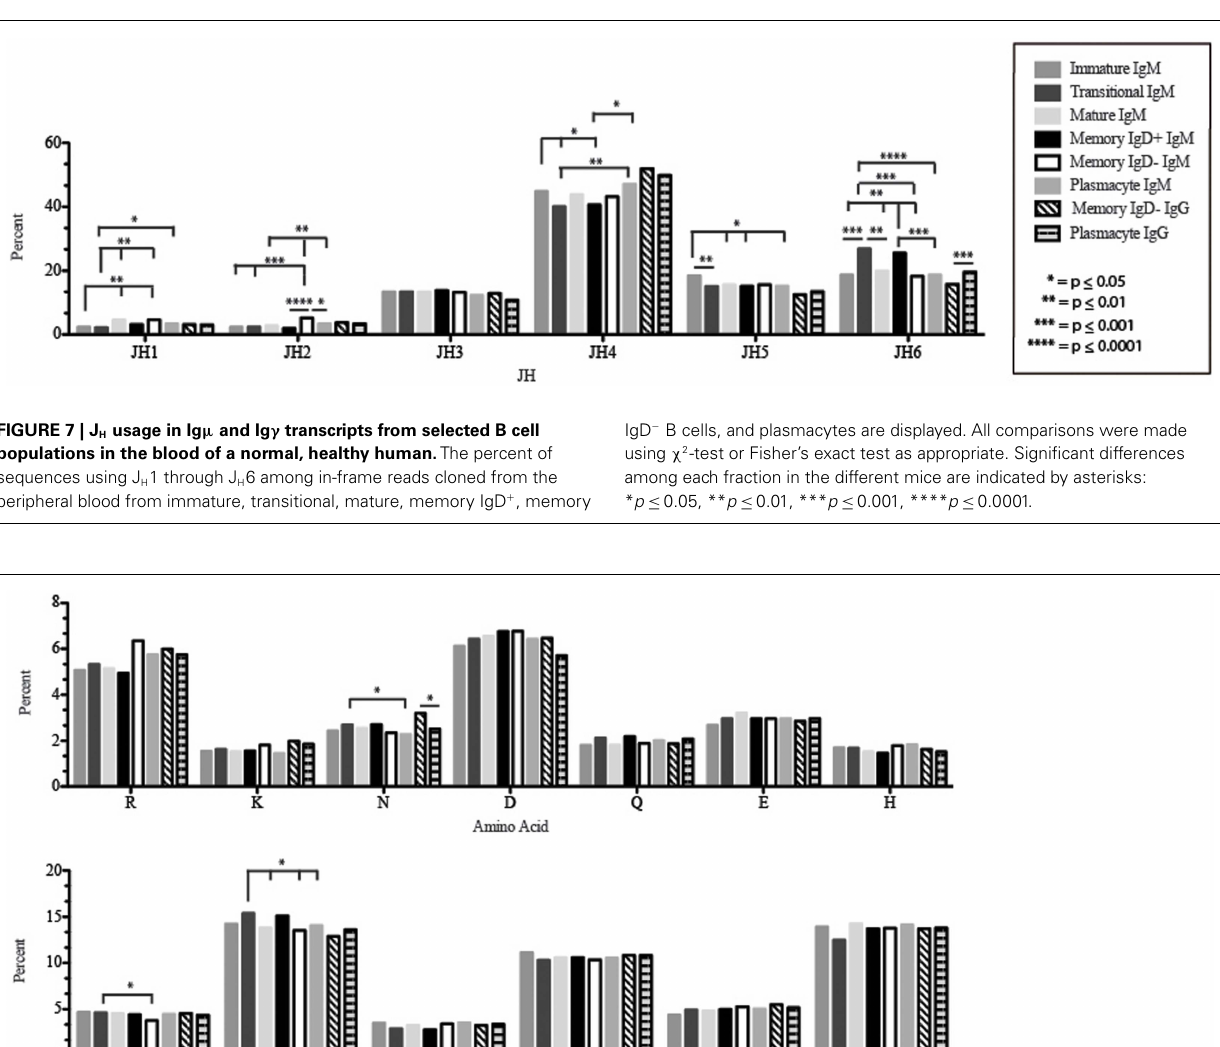
comparisons were made using χ 2 -test or Fisher’s exact test as appropriate. Significant differences among each fraction in the different mice are indicated by asterisk: * p <